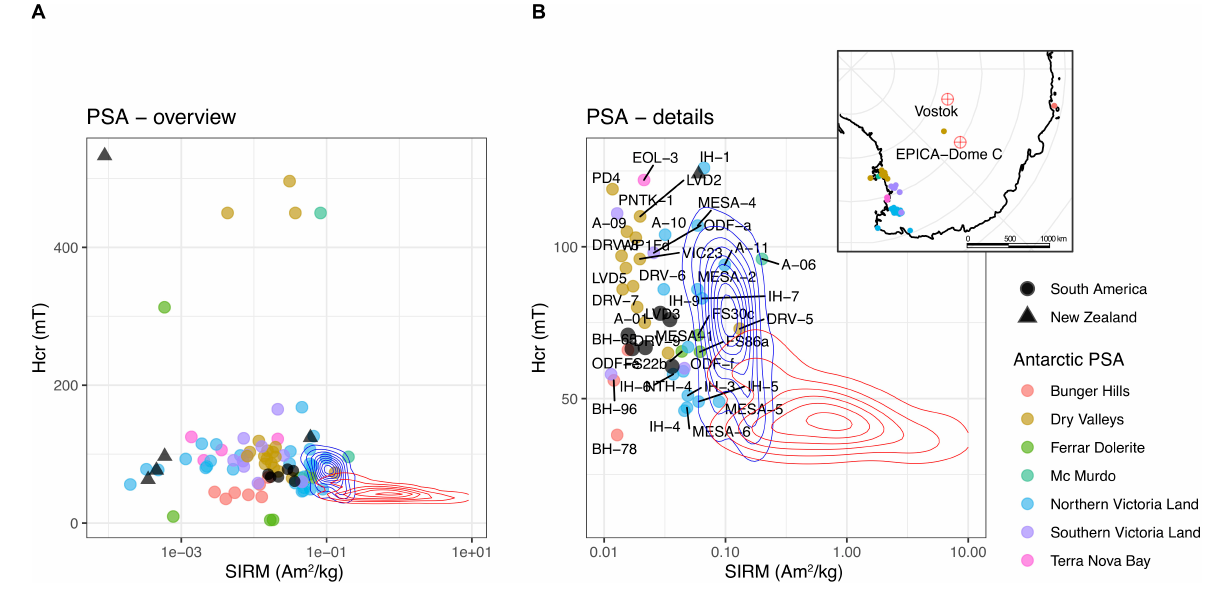
Frontiers in Earth Science |